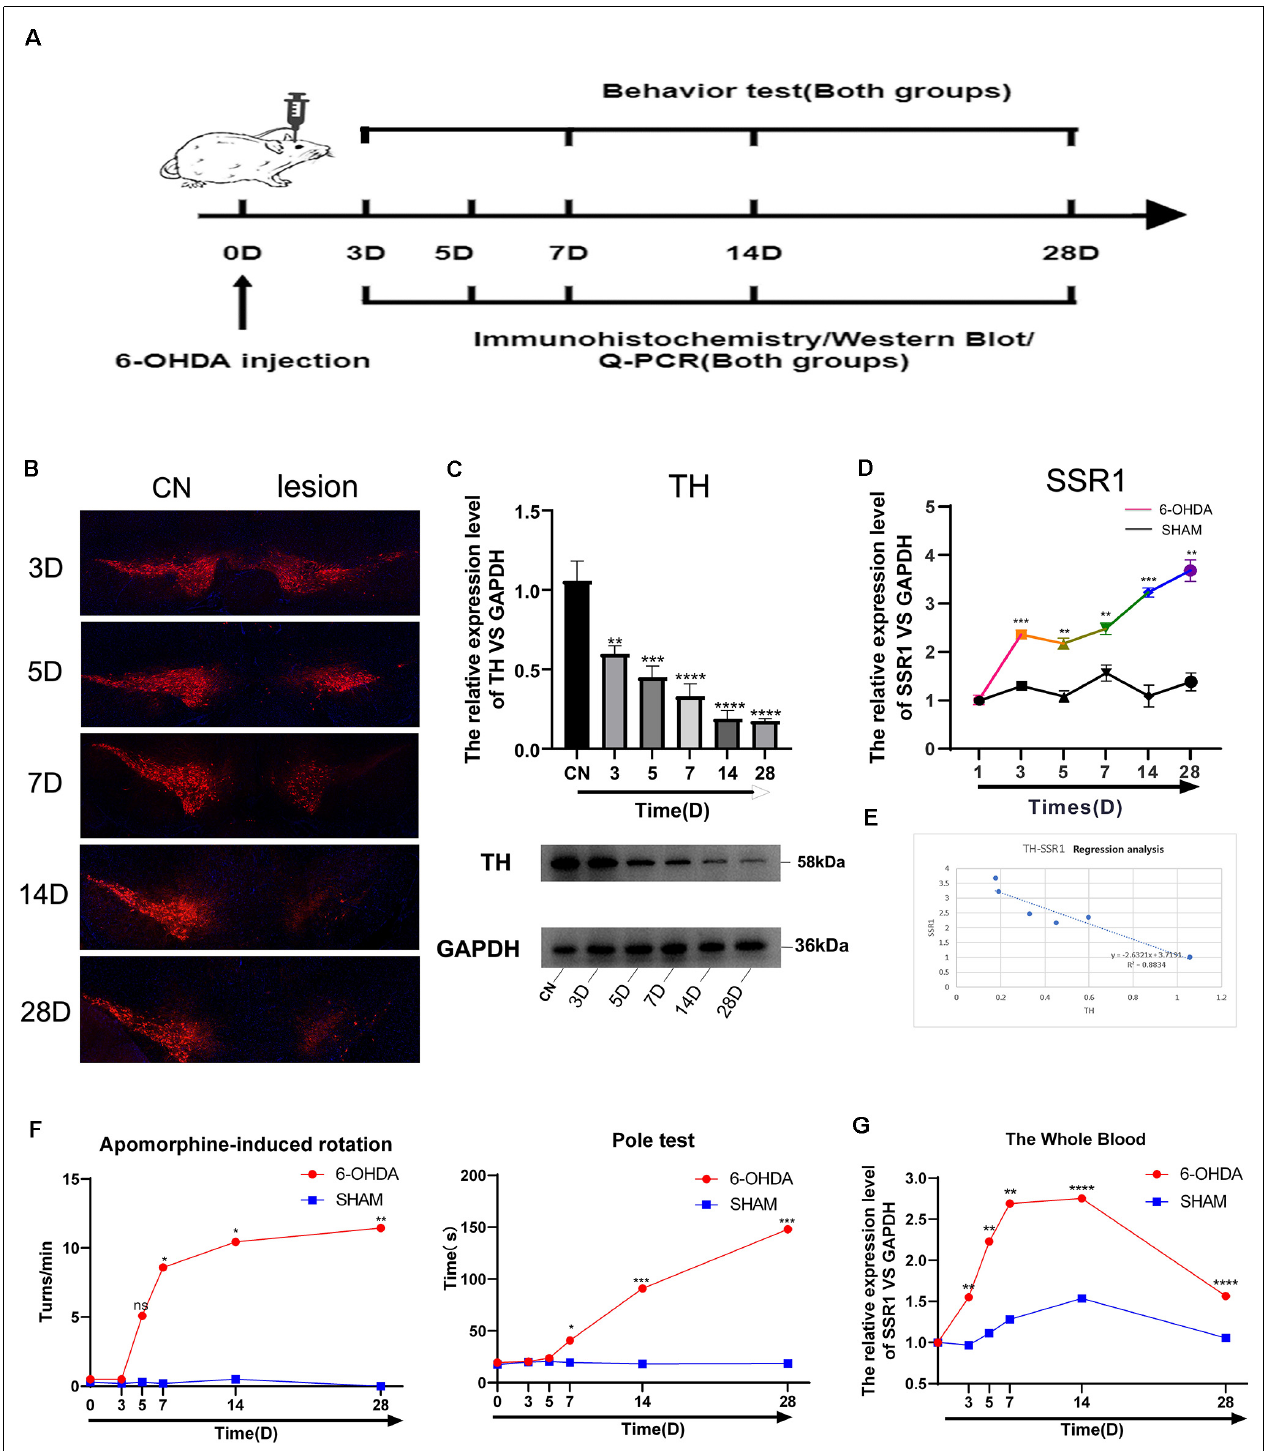
FIGURE 7 | Longitudinal study of SSR1 expression in vivo . (A) The flowchart of the construction of the 6-OHDA subacute model, behavioral tests, and sacrifice. (B) Tyrosine hydroxylase (TH) staining of the substantia nigra (SN) of the above mice. Scale bars: 200 µ m. (C) Western blot analyses of TH in SN of the above mice. (D) The mRNA relative expression levels of SSR1 in SN of the above mice. (E) The correlation analysis of SSR1 and TH in SN. (F) Pole tests and apomorphine-induced rotation were conducted by a blinded observer after 6-OHDA treatment. (G) The mRNA relative expression levels of SSR1 in the whole blood of the above mice. ns p > 0.05, * P < 0.05, ** P < 0.01, *** P < 0.001, **** P < 0.0001 vs. Control group.